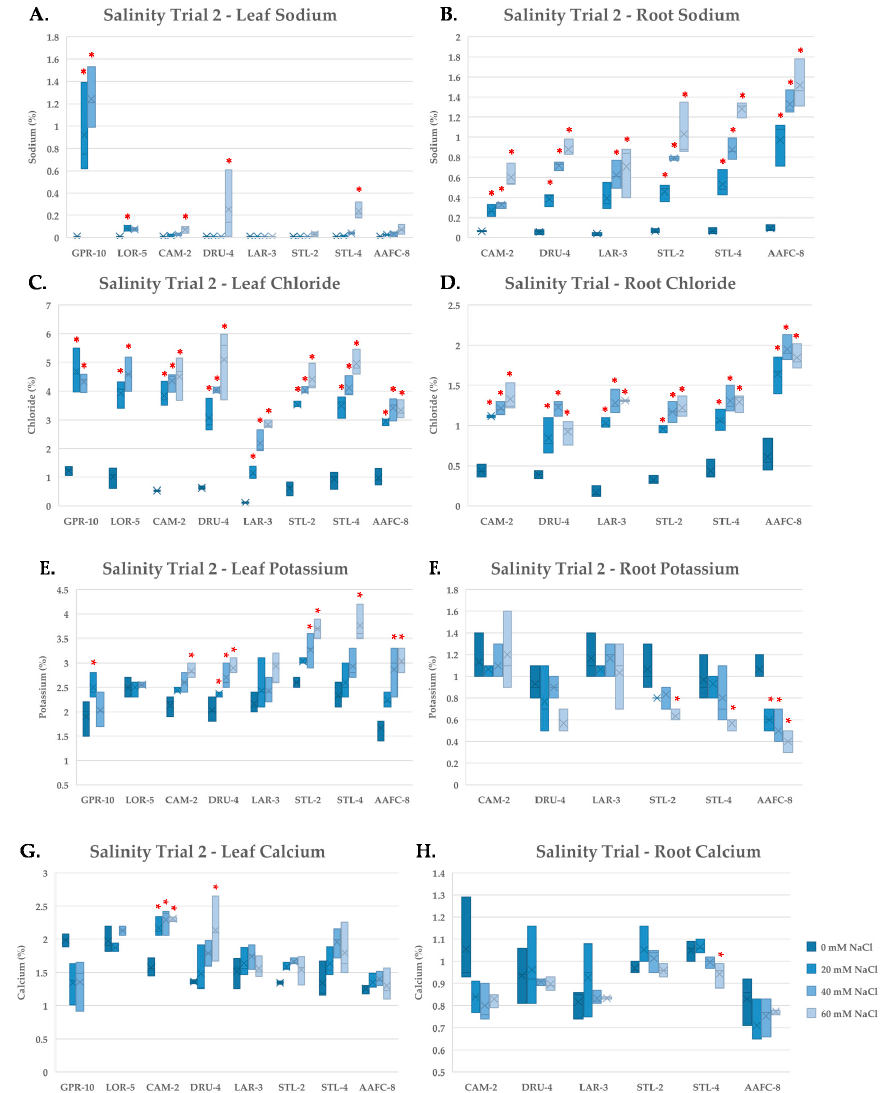
Figure 5. Sodium ( A , B ), chloride ( C , D ), potassium ( E , F ) and calcium ( G , H ) content of leaf ( A , C , E , G